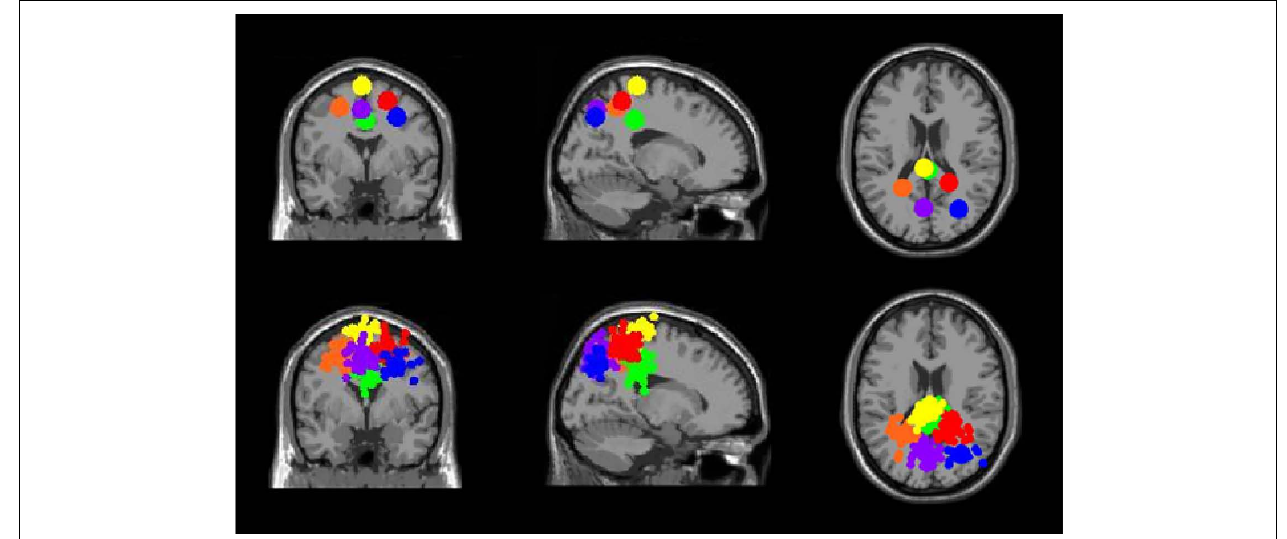
FIGURE 4 | Clusters of electrocortical sources with significant spectral shifts time-locked to stimulus presentation during the Brooks spatial working memory task. Green is the central posterior cingulate (BA 6), blue is the right somatosensory association cortex (BA 7), orange is the left somatosensory association cortex (BA 7), purple is the middle somatosensory association cortex (BA 7), red is the right